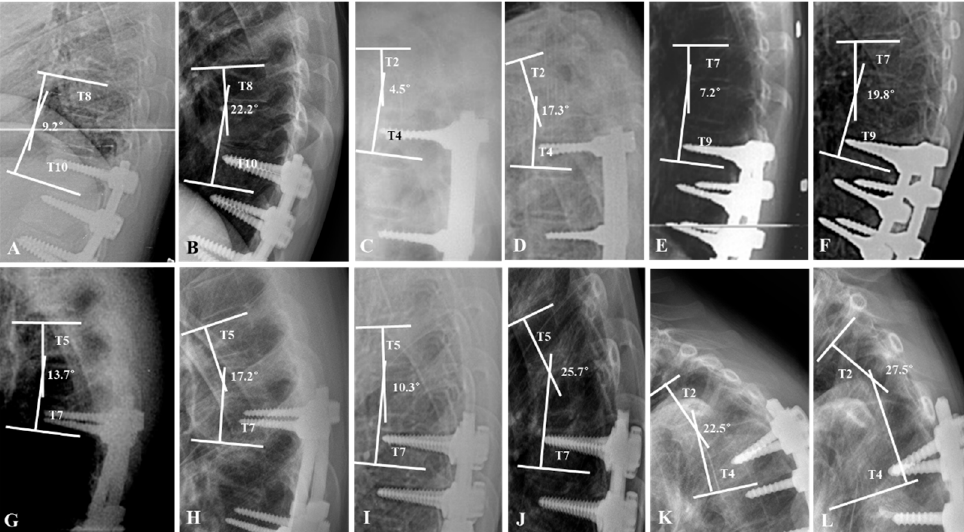
Figure 2. The profiles of the proximal junctional kyphosis (PJK) groups. A 15-year-old female patient underwent deformity correction from T10 to L4. The proximal junctional angle (PJA) was progressed from 9.2° to 22.2° at 1-year follow-up ( A , B ). A 14-year-old female patient underwent deformity correction from T4 to L3. PJA was progressed from 4.5° to 17.3° at 2-year follow-up ( C , D ). A 13-year-old female patient underwent deformity correction from T9 to L4. PJA was progressed from 7.2° to 19.8° at 6-month follow-up ( E , F ). A 15-year-old male patient underwent deformity correction from T7 to L2. PJA was progressed from 13.7° to 17.2° at 6.5-year follow-up ( G , H ). A 13-year-old female patient underwent deformity correction from T7 to L3. PJA was progressed from 10.3° to 25.7° at 1-year follow-up ( I , J ). A 14-year-old female patient underwent deformity correction from T4 to T12. PJA was progressed from 22.5° to 27.5° at 6-month follow-up ( K , L ).